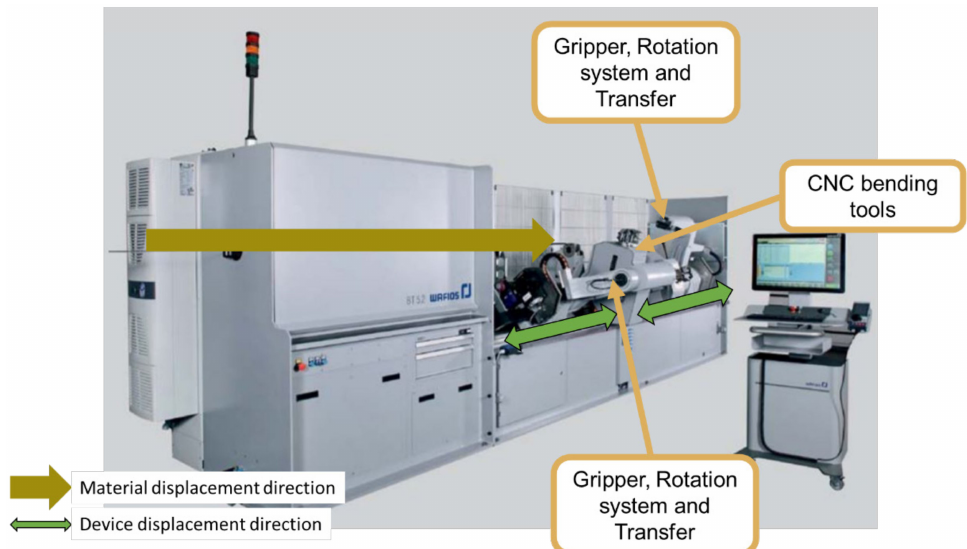
Figure 10. Wire-bending equipment BT5.2.